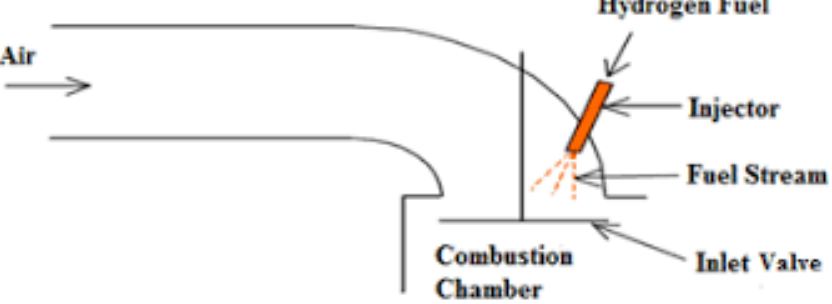
Figure 4. Inlet Manifold and Inlet Port Injection Method [67].